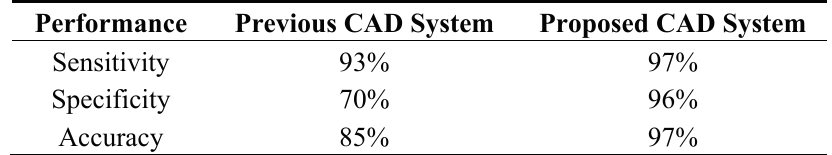
Table 7. Performance criteria of the computer aided diagnosis (CAD)